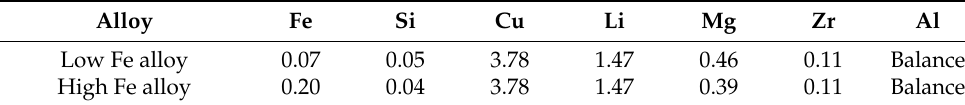
Table 1. Nominal composition of the Al-Cu-Li-Mg-Zr alloys (wt. %). Alloy Fe Si High Fe